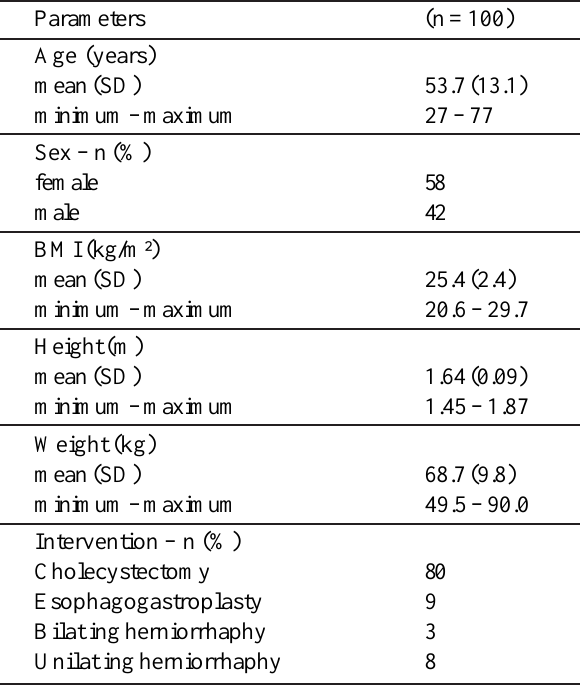
TABLE 1 - Descriptive statistics of the demographic